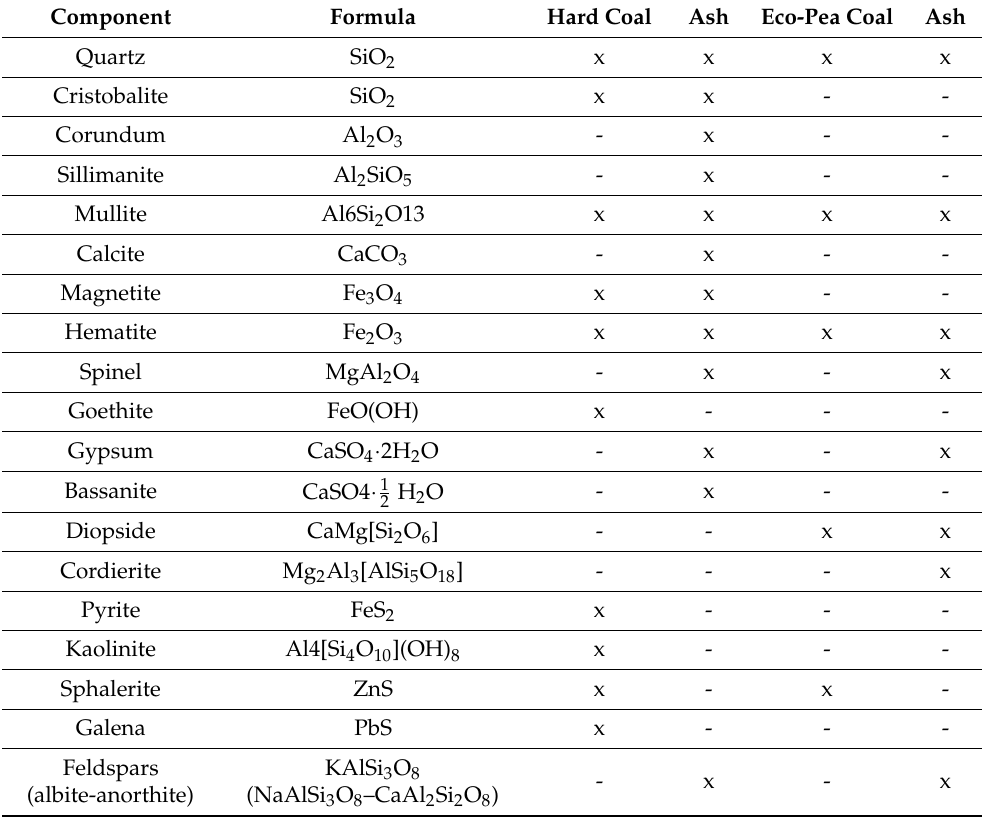
Table 1. Mineral composition of coal and ash from individual domestic furnaces on the basis of XRD